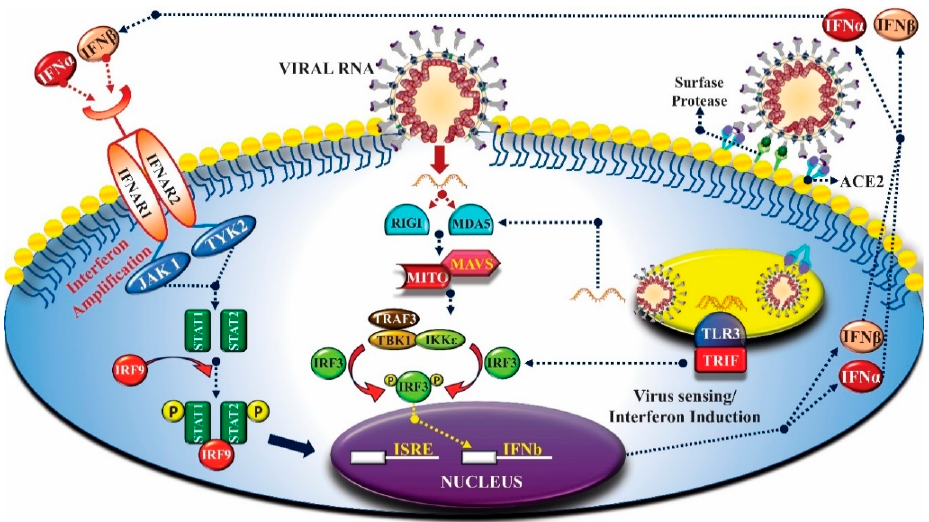
Figure 4. IFN signaling and synthesis pathway. RNA viruses can be internalized in the target cell by different mechanisms: (A) fusion with the plasma membrane or; (B) binding to a surface receiver (ACE2 for SARS-CoV-2 and SARS-CoV). After internalized, the virus exposes the genomic RNA to the dsRNA detection mechanism in the cell, that is, TLR3, RIGI and MDA5. These proteins are responsible for the IRF-3 cascade signaling, leading to IFNb induction and, consequently, the production of IFN β protein. The newly synthesized IFN β can bind to IFN receptors on the surface of the same cell or surrounding cells and induce the synthesis of more IFN molecules. Binding to IFN receptors activates the signal transducer and activator of transcription 1 (STAT1) signaling pathway to activate several distinct antiviral genes located in ISRE promoter elements [21,55]. Note: This image was developed using the CorelDraw software (2017 Corel Corporation ID 410003). The complement system plays a crucial role in the innate immune response to viruses. It represents one of the main factors responsible for the development of pro-inflammatory reactions during these diseases [56,57]. Research has shown that, just as in human infection, intranasal SARS- CoV infection in C57BL/6J mice, results in virus replication with high rates in the lung, in addition to induction of inflammatory cytokines and chemokines and infiltration of immune cells in the pneumocytes [58]. Using C3-deficient mice (C3 -/- ), these researchers demonstrated that animals C3 - /- infected with SARS-CoV lost less weight and obtained a significant reduction in respiratory dysfunction when compared to control groups, despite viral loads equivalent in the lung. Besides, a significantly lower rate of neutrophils and inflammatory monocytes were present in the lungs of C3 -/- mice than in the C56BL/6J controls, and subsequent studies showed that lung injury was reduced, as were cytokine (IL-6, mainly) and chemokine levels in lungs and serum of C3 -/- mice than when purchased from animals in the control group [58]. This suggests that C3 inhibition may significantly reduce the pulmonary inflammatory complications of SARS-CoV-2 infection. The decrease in neutrophilic infiltration in the lungs and the reduced levels of intrapulmonary and plasma IL-6 that have been observed in mice with C3 -/- infected with SARS-CoV suggest a potential treatment that combines C3 inhibitors and anti-IL-6 drugs [59]. Besides, as C3 is one of the first proteins synthesized by the complement system in the innate immune cascade, the anti-inflammatory potential for C3 blockage is broader. Drugs like AMY-101 are being investigated for this [60], which is currently being tested in patients with COVID-19 [59]. C3 blockade can simultaneously inhibit the synthesis of C3a and C5a. Furthermore, this block reduces the intrapulmonary activation of C3 and the release of IL-